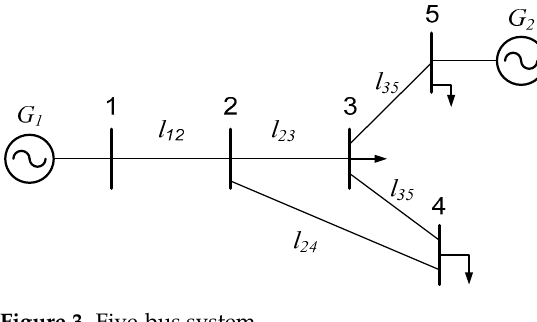
Figure 3. Five-bus system. Table 1. Bus information of the five-bus system.